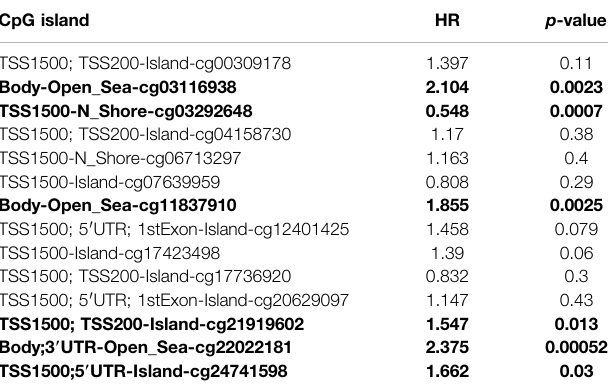
TABLE 1 | Effects of methylation levels in the CpG sites of the EXO1 gene on the prognosis of HCC patients. CpG island HR